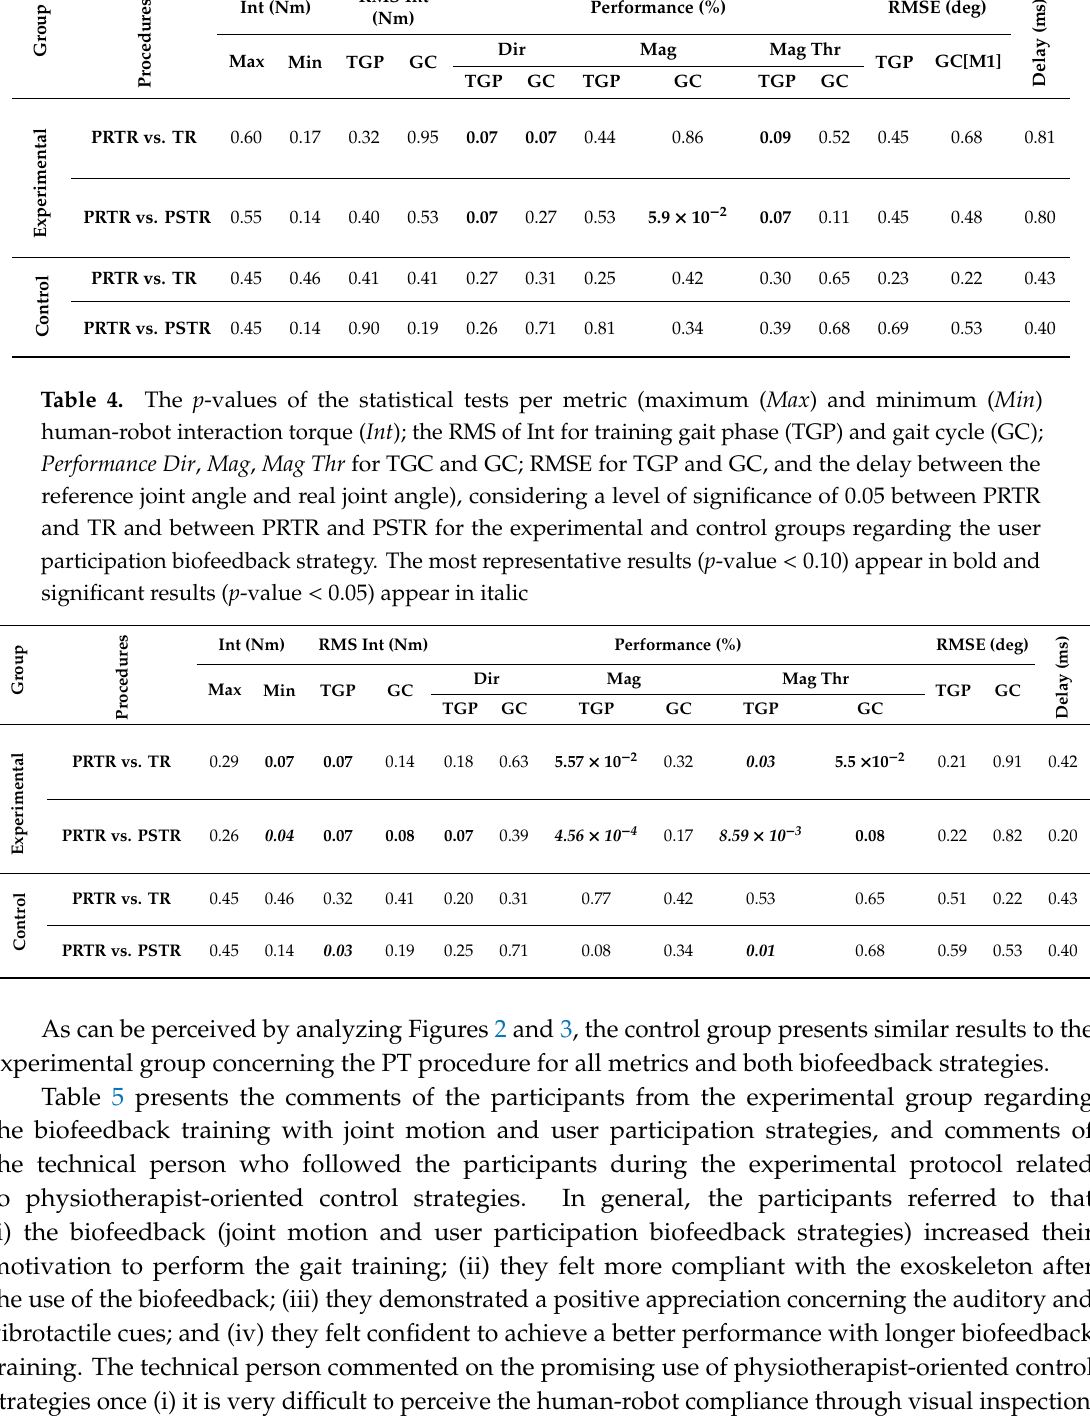
Table 3. The p -values of the statistical tests per metric (maximum ( Max ) and minimum ( Min ) human-robot interaction torque ( Int ); RMS of Int for the training gait phase (TGP) and gait cycle (GC); Performance Dir, Mag, Mag Thr for TGC and GC; RMSE for TGP and GC; and the delay between the reference joint angle and real joint angle), considering a level of significance of 0.05 between procedures PRTR and TR and procedures PRTR and PSTR for the experimental and control groups regarding joint motion biofeedback strategy. The most representative results ( p -value < 0.10) appear in bold upP o G r